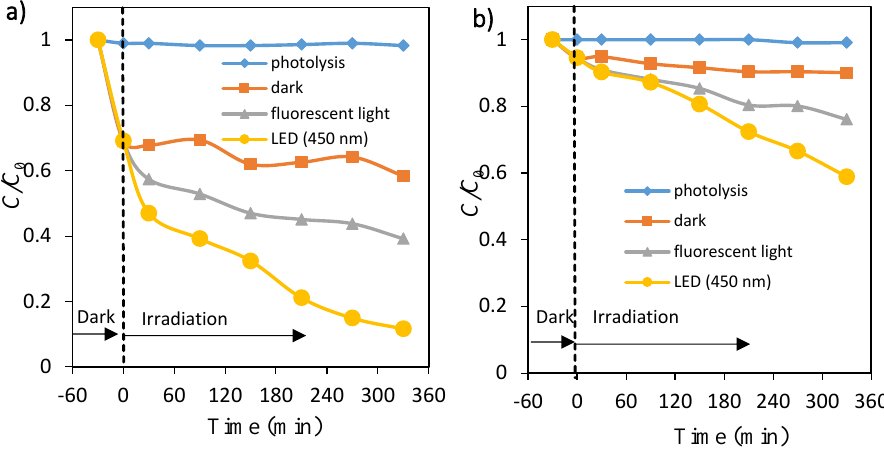
Figure 3. Time courses of concentration of orange II ( a ) and methyl orange ( b ). Photolysis: ♦ , TiO 2 dispersions: under dark ■ , under fluorescent light irradiation ▲ and under LED light irradiation ● .